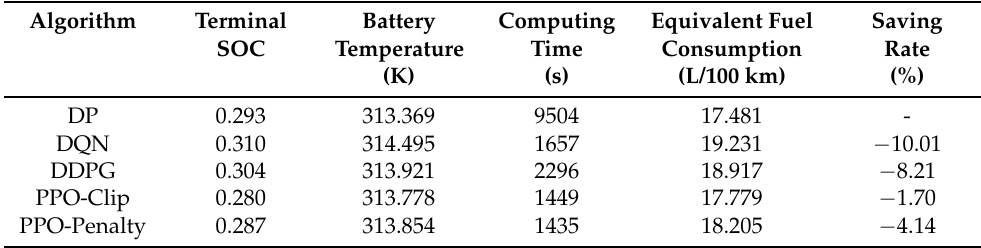
Table 6. The simulation results in 4 × UDDS.